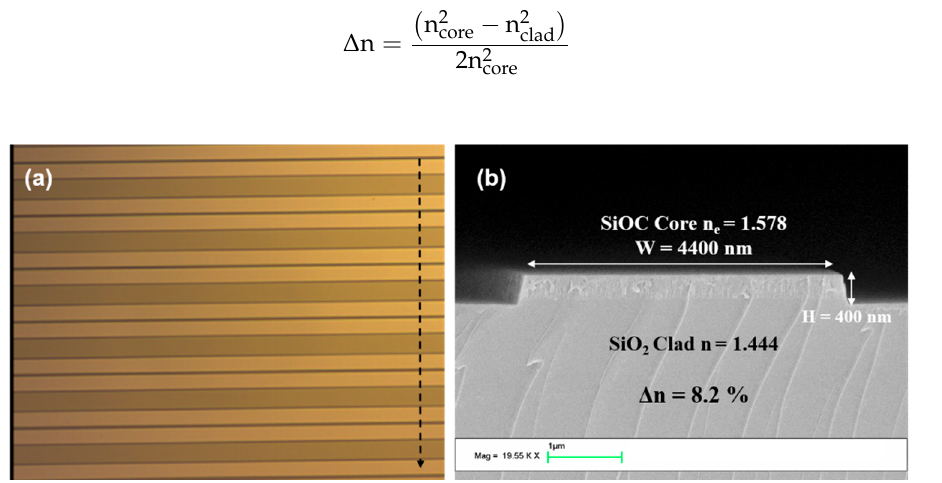
Figure 7. ( a ) Optical micrograph of straight SiOC waveguides with different widths (increasing from top to bottom with arrow) captured with optical microscope after photoresist lift-off, ( b ) high resolution SEM image of SiOC channel waveguide with dimensions (width W = 4400 nm by height H = 400 nm).